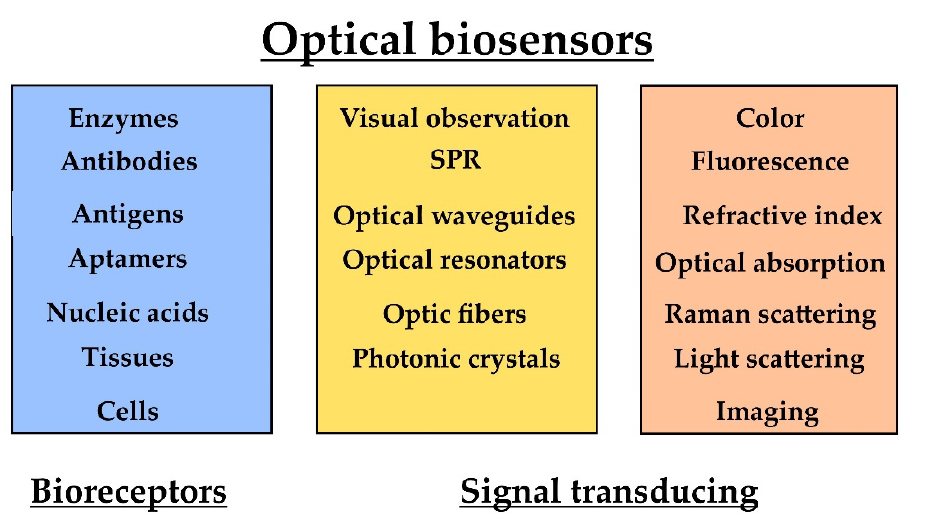
Figure 5. The basic components of optical biosensors. The interaction of the targeted analyte with the bioreceptors changes the optical properties of